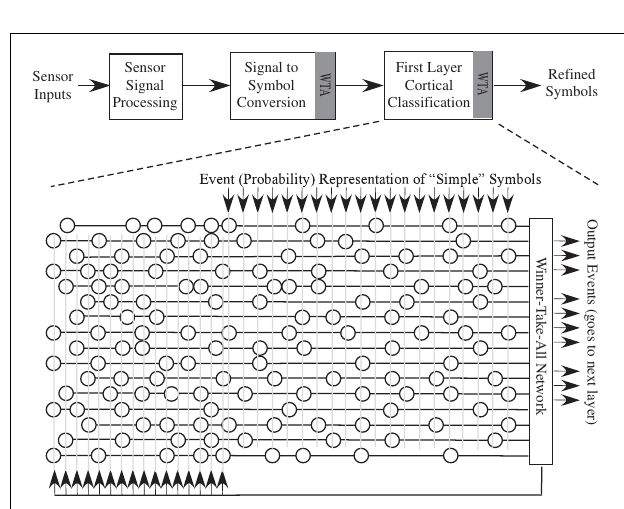
FIGURE 12 | Modeling a group of neurons using a Winner-take-all (WTA) network, along with the synaptic weighting through a typical VMM approach. WTA has inspiration from the interactions of cortical somas and coupled inhibitory interneurons. These approaches allow for a small number of winning neurons, and sharpens up the neuron responses as well as reduces the overall spike rate. The computational power of this approach, whether using spiking neurons or as circuit implementation using a range of dynamics is still an active area of research.